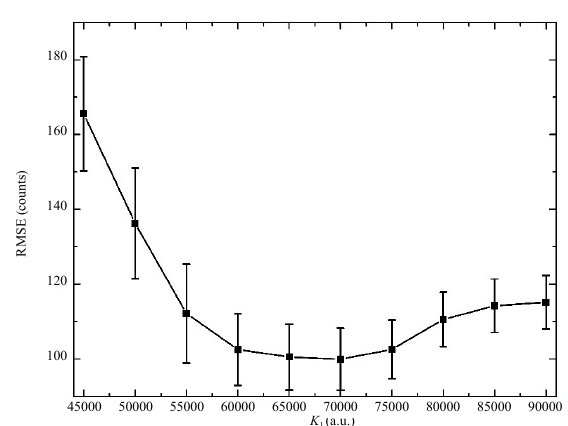
Fig. 6 Relationship between the parameter while 0.005 α= and